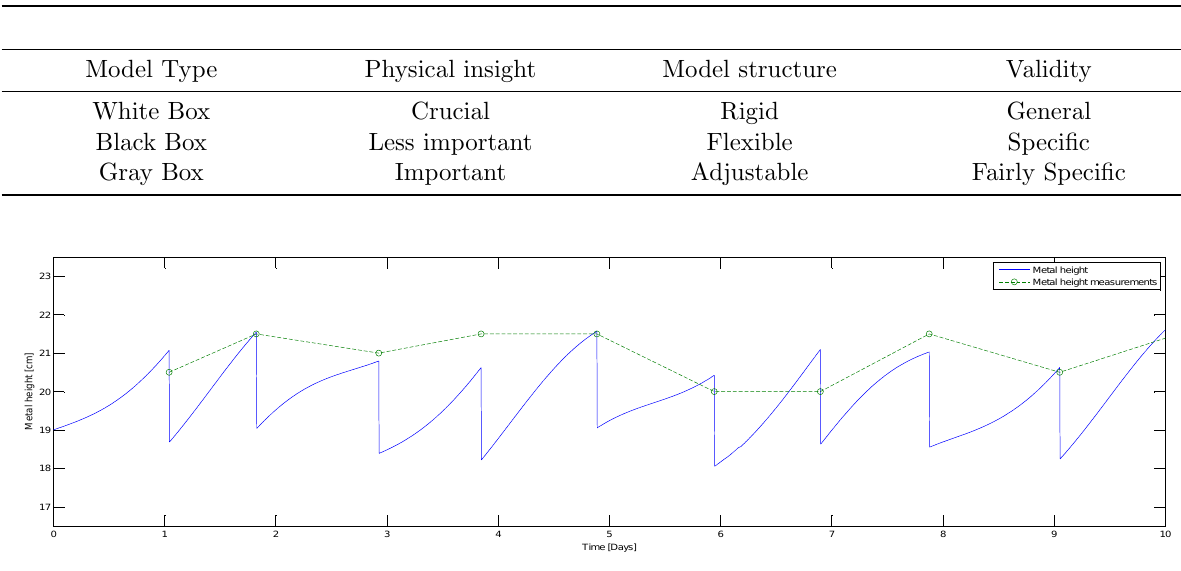
Table 2: Different “Box”Systems in conjunction with modeling and their overall characteristics